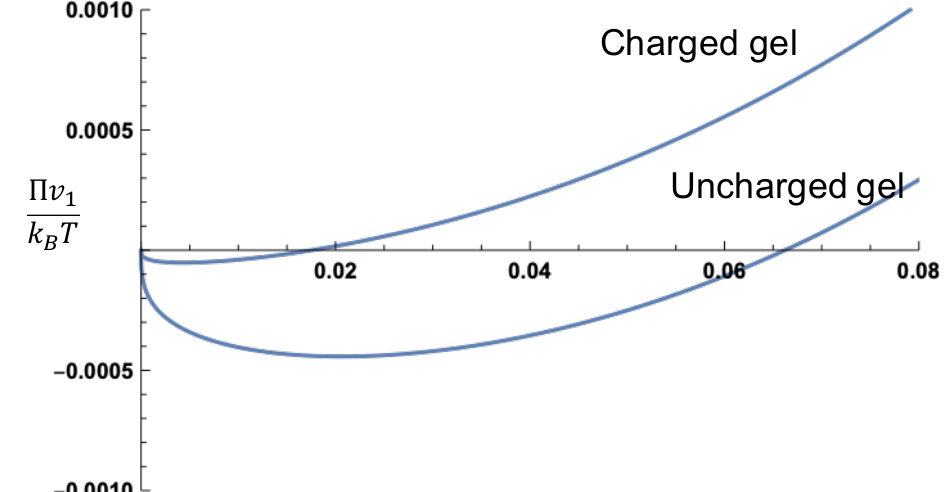
Figure 3. Comparison of the osmotic pressures of an uncharged gel and a charged gel. The values of the parameters are the same as in Figure